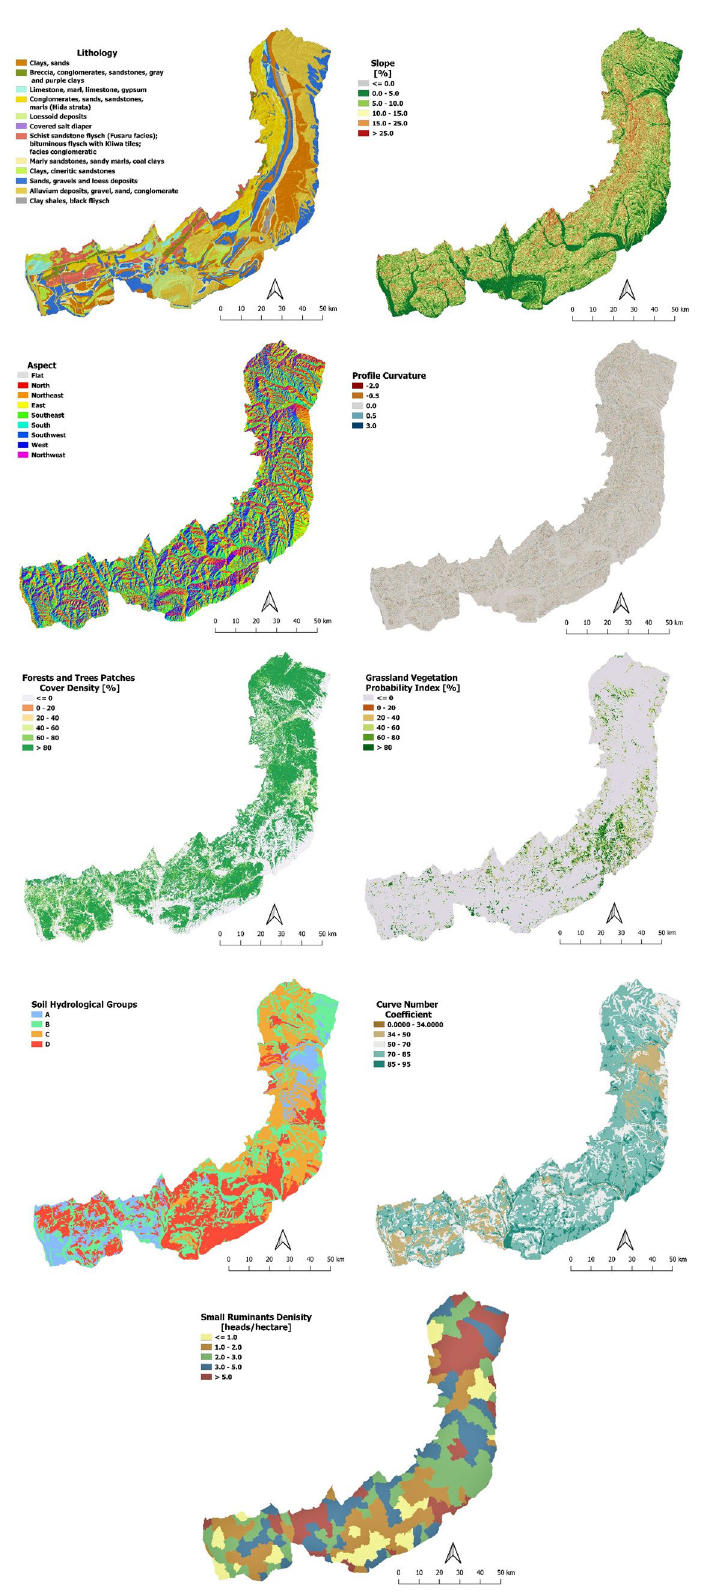
Figure 4. Curvature Subcarpathians geographic factors: ( a ) Lithology; ( b ) Slope angle; ( c ) Aspect; ( d ) Profile Curvature; ( e ) Forest and Trees Patches Cover Density; ( f ) GRAVPI; ( g ) Hydrologic Soil Groups; ( h ) Curve number; ( i ) SRs Density. The map was created by N. Ciobotaru using the QGIS version 3.20 (https:// www. qgis.